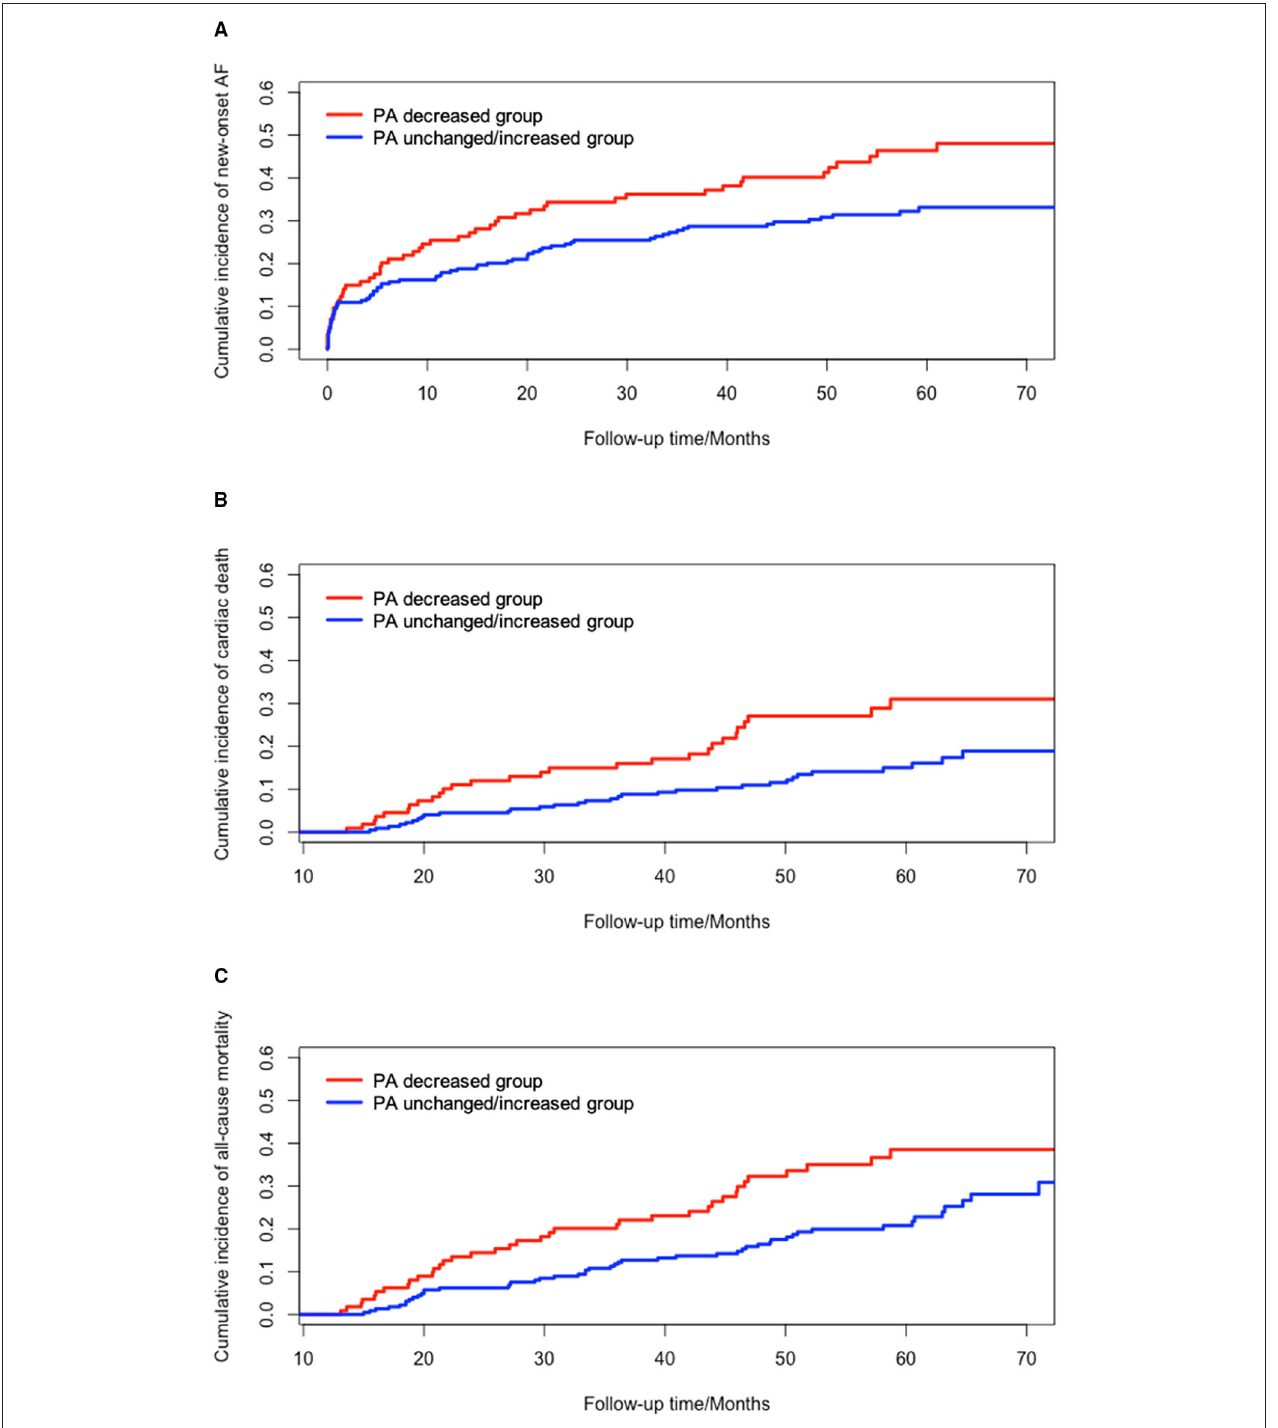
FIGURE 2 | Univariate survival analysis of changes in PA and clinical outcomes. (A) cumulative incidence of new-onset AF between PA decreased group and PA unchanged/increased group ( P = 0.013); (B) cumulative incidence of cardiac death between PA decreased group and PA unchanged/increased group ( P = 0.007); (C) cumulative incidence of all-cause mortality between PA decreased group and PA unchanged/increased group ( P = 0.010). AF, atrial fibrillation; PA, physical activity.